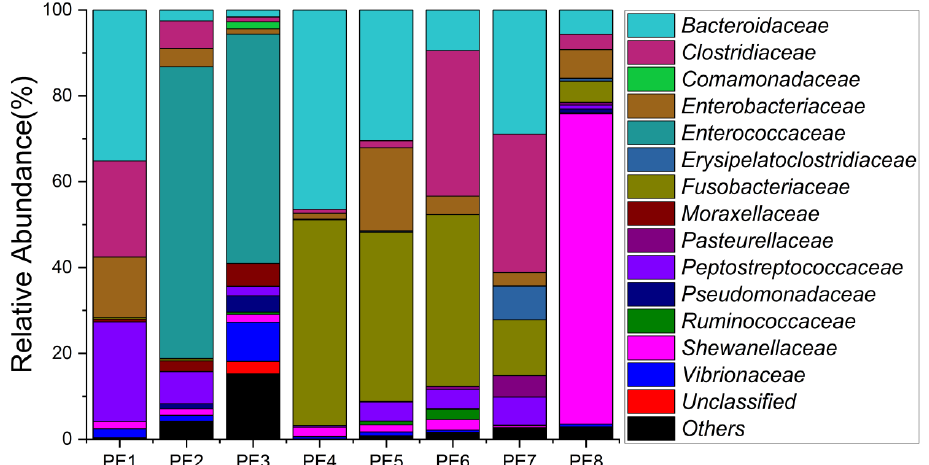
Figure 3. Gut microbial community members of eight stranded melon-headed whales (PE1-8) at the family level.